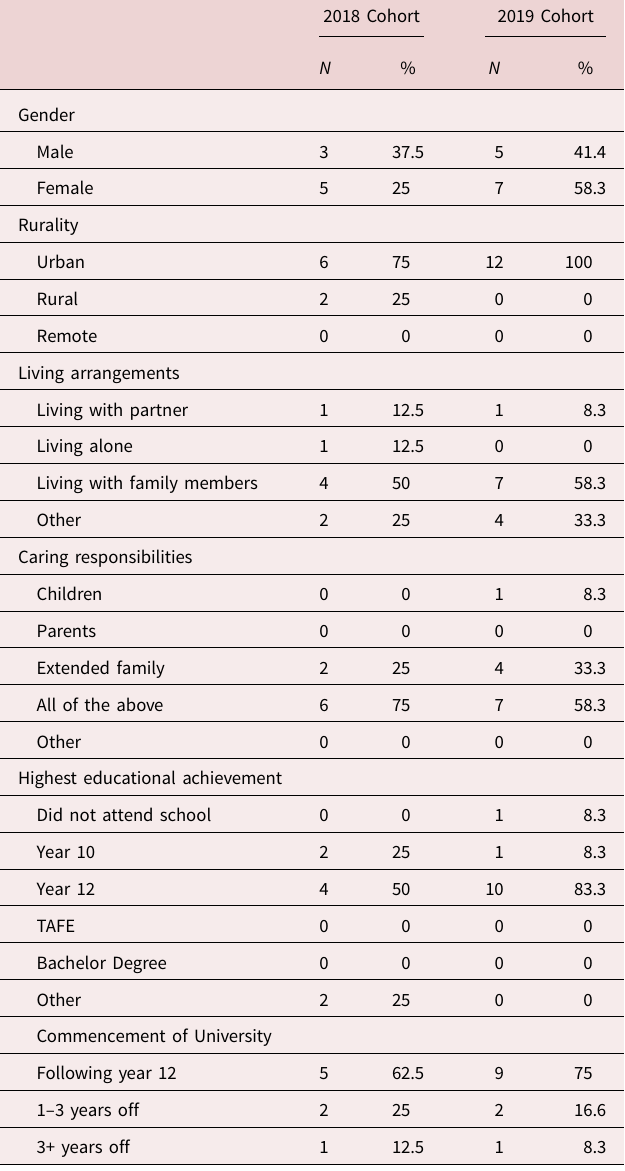
Table 1. Summary of participant characteristics ( N